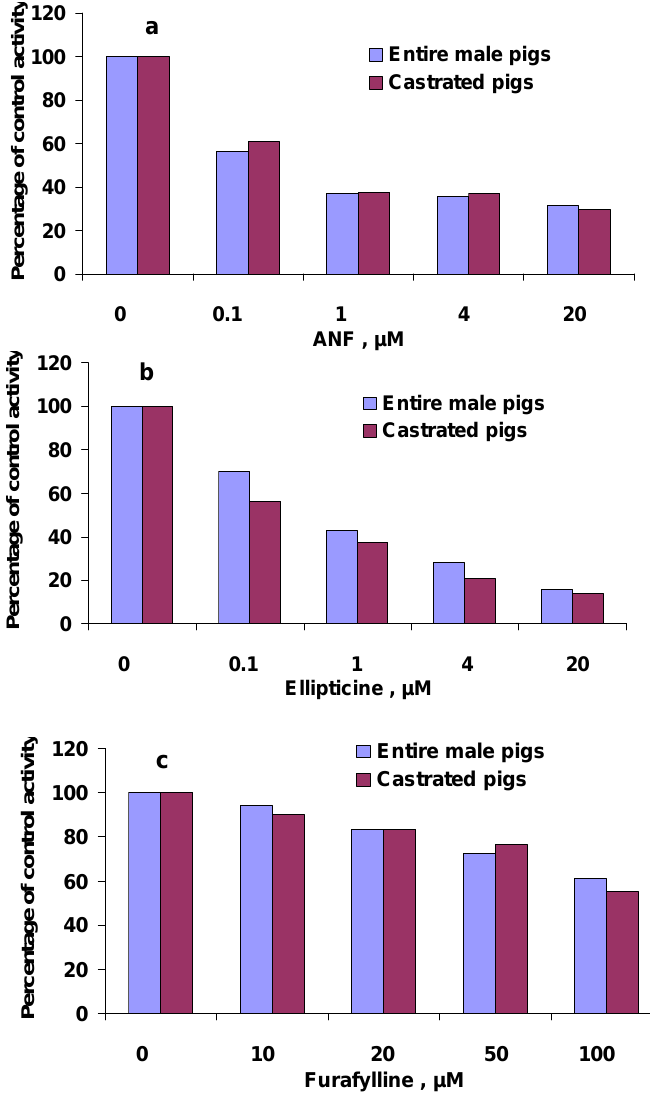
Figure 5. Inhibition of 7-methoxyresorufin O -demethylation (MROD) in hepatic microsomes from entire and castrated male pigs by ANF (a), ellipticine (b) and furafylline (c). Assays were performed as described in the Experimental section. Values are expressed as percentages of activities in control incubations and are the mean of duplicates (differences between the duplicates were below